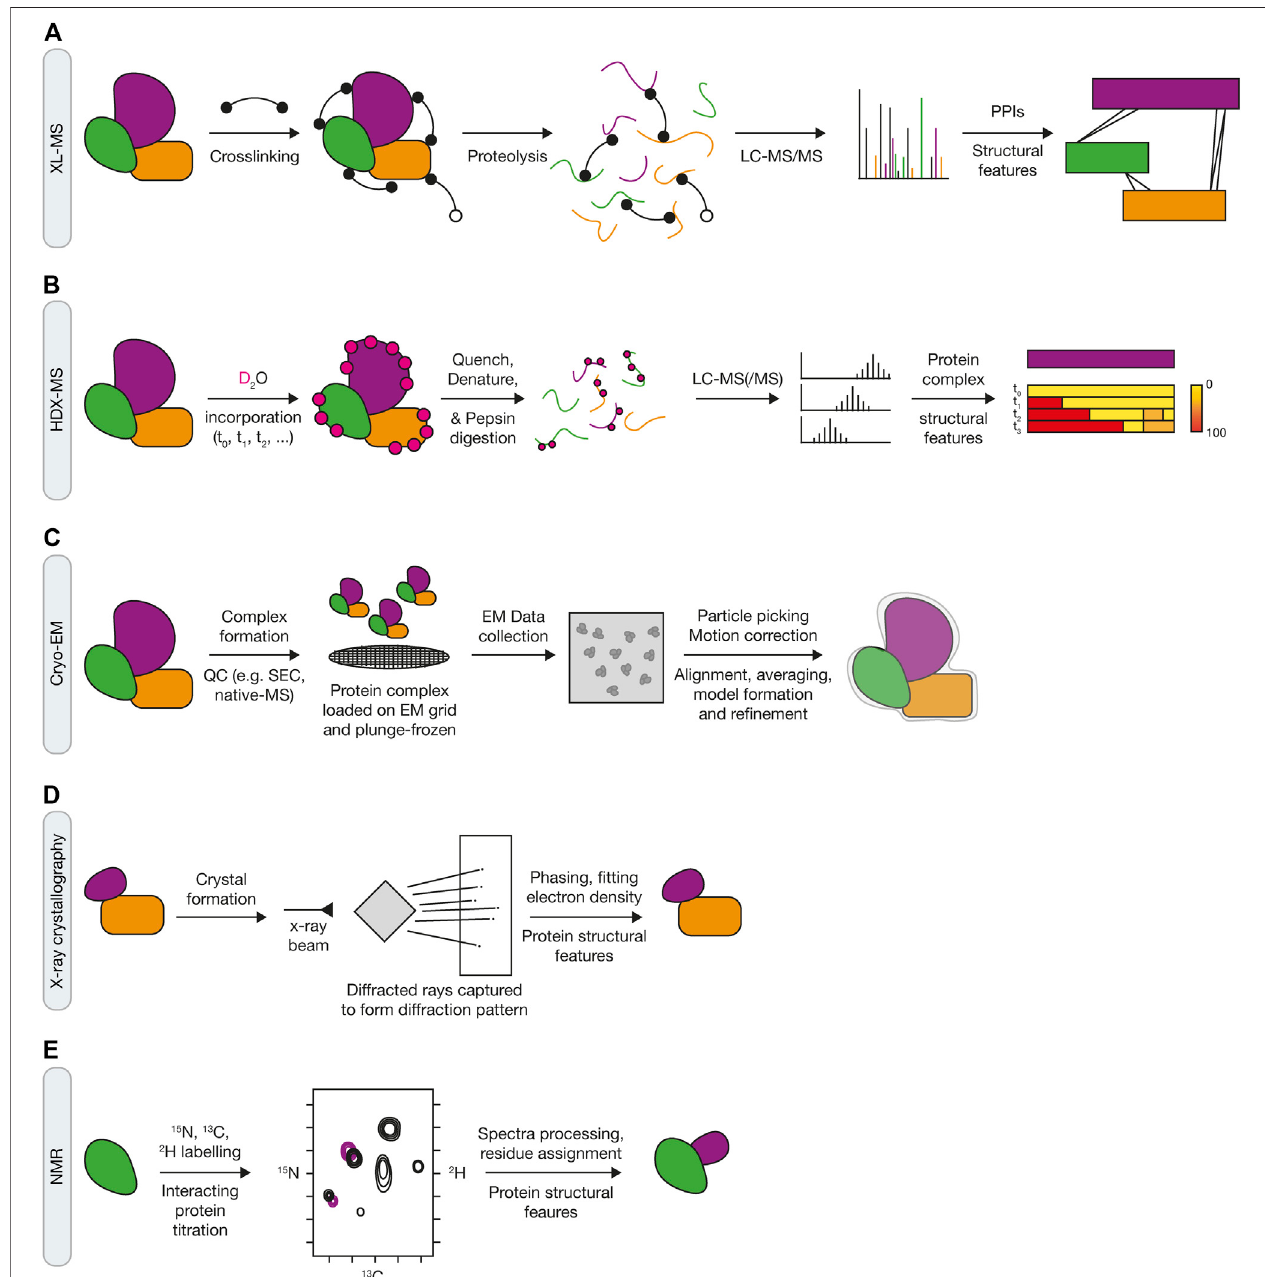
FIGURE 6 | Integrated structural approaches to investigate mechanisms of ubiquitin signaling in the DDR. (A) Crosslinking with mass spectrometry (XL-MS) requires the use of chemical crosslinkers to react with amino acid side chains, such as BS3 NHS-ester chemistry for primary amines on lysine residues or N-termini of proteins. Subsequent proteolysis with Trypsin or LysC, tandem mass spectrometry and data analysis using specialised software enables identi fi cation of crosslinked peptide species. (B) Hydrogen-deuterium mass spectrometry (HDX-MS) relies on the incorporation of 2 H into the protein by incubation in deuterated water. The experiment uses a time course of 2 H-incorporation followed by a rapid quenching and denaturation step at pH 2.5 before pepsin digestion and mass spectrometry analysis. Specialised data analysis pipelines can assess differences in 2 H-incorporation for a protein across experimental conditions. (C) Single particle cryo-electron microscopy (cryo-EM) has recently evolved as a technique to get high-resolution structural data of larger multi-protein assemblies. Protein samples go through several stages of quality control (QC) via biochemical and biophysical techniques (e.g., SEC and native mass spectrometry) before loading onto carbon-coated EM grids, plunge-freezing in liquid ethane and data collection using high-power electron microscopes. (D) X-ray crystallography and (E) nuclear magnetic resonance (NMR) are established techniques to gain atomic-level resolution of protein structures that relies on the formation of crystals and isotopically labelled proteins, respectively.